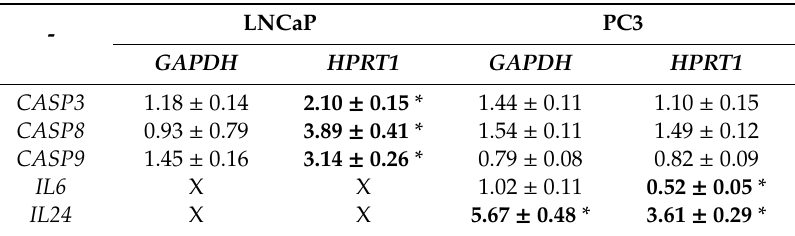
Table 4. Normalized differential gene expression in cell lines after treatment with WCP from H. novae- zealandiae .